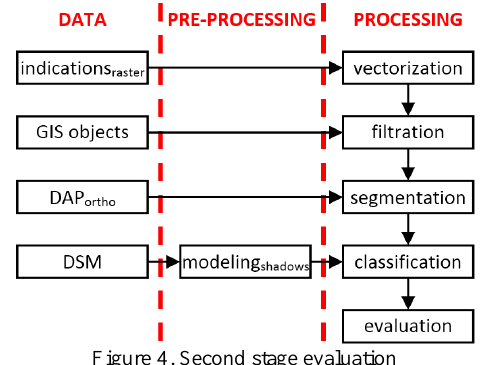
Figure 4. Second stage